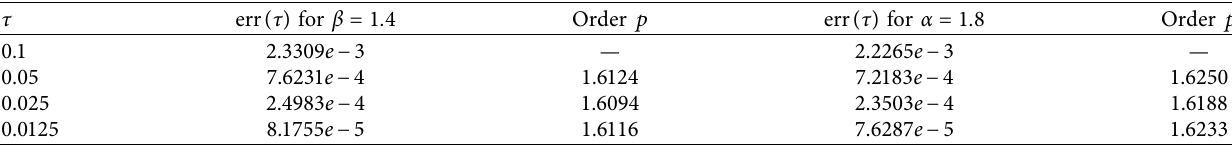
Table 1: Temporal convergence rates of the two-step ETD scheme with Pad´e approximation for FCNLSE (32) with α � 0 . 6. τ err ( τ ) for β � 1 . 4 err ( τ ) for α � 1 . 8